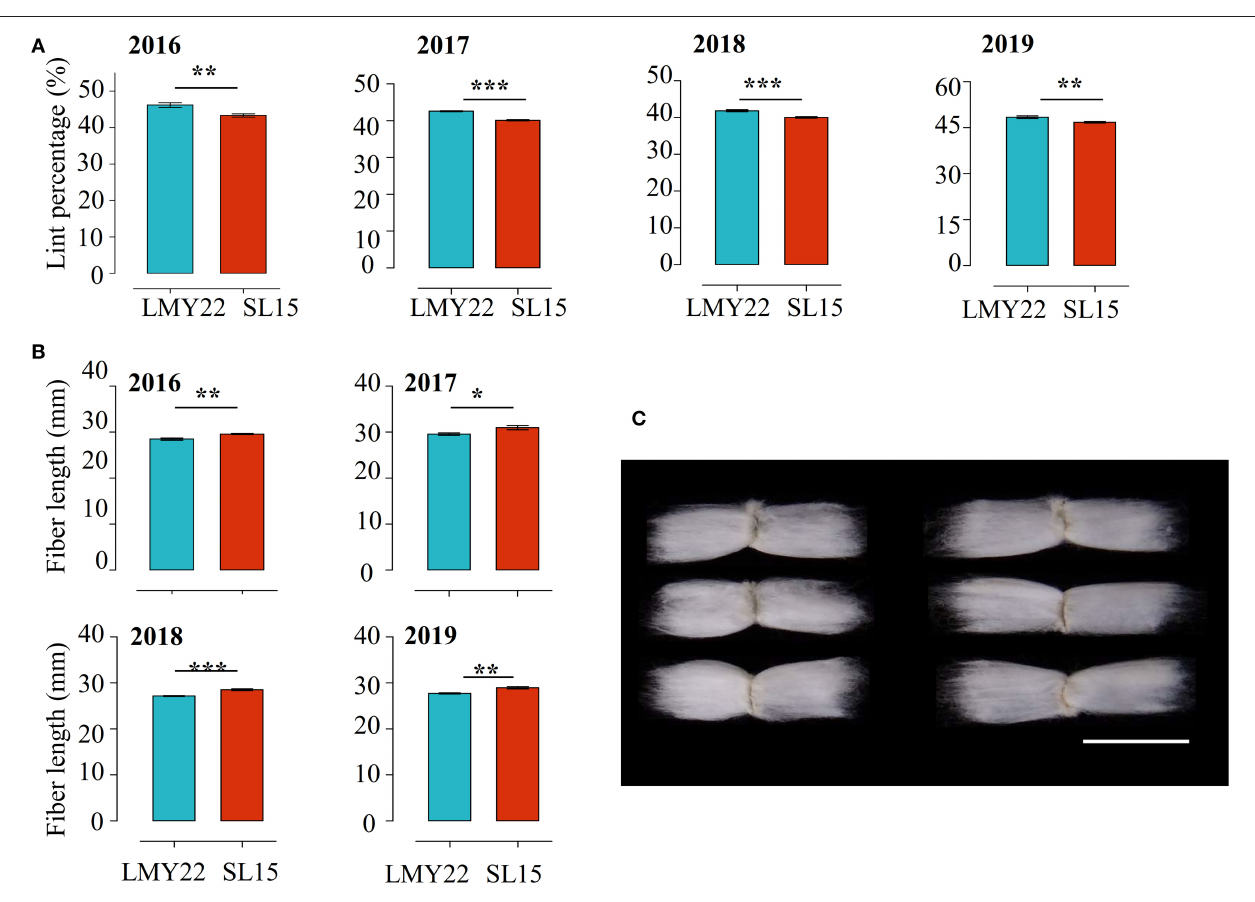
FIGURE 1 | Multi-year field data comparisons. (A) Lint percentage and (B) fiber length in LMY22 and SL15 during a four-year field trial from 2016 to 2019 (mean ± s.d., n = 5, * P < 0.05, ** P < 0.01, *** P < 0.001). (C) Representative fiber images from LMY22 (left) and SL15 (right). Scale bar, 3cm.